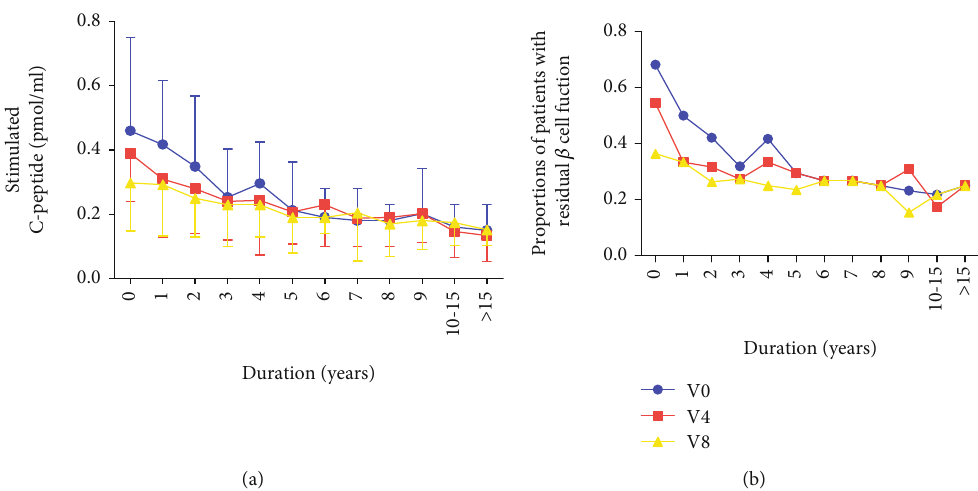
Figure 1: β -cell function by duration of diabetes. Changes of C-peptide in T1DM with di ff erent diabetes duration during di ff erent visits (a). Changes of proportion of individuals with residual β -cell function during di ff erent visits (b). In the individuals with duration < 5 years, stimulated C-peptide at V0 was signi fi cantly di ff erent with C-peptide at V4 ( P < 0 : 05 ) and V8 ( P < 0 : 05 ), the proportion of individuals with residual β -cell function at V0 was signi fi cantly higher than that V4 ( P < 0 : 05 ) and V8 ( P < 0 : 05 ). Among those with duration ≥ 5 years, there were no signi fi cant di ff erences in stimulated C-peptide levels among them. V0: the 0th visit; V4: the 4th visit; V8: the 8th visit.